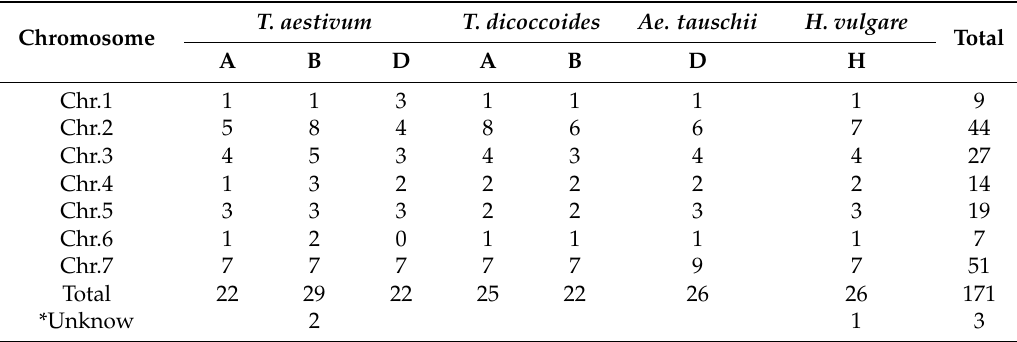
Table 2. Number of EXO70 from different species in each of the